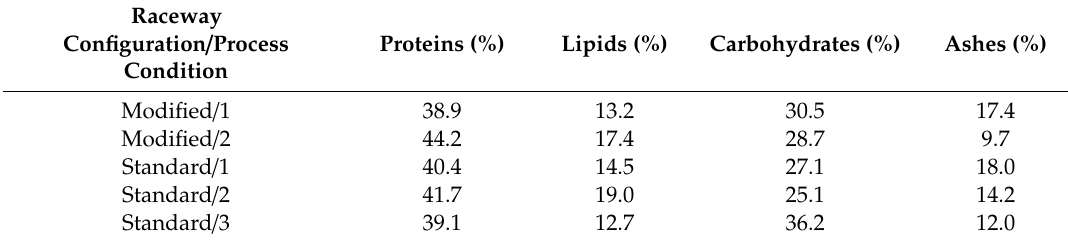
Table 5. Biomass proximate composition. Values are presented relative to dry weight. Values represent an average of two biological replicates.